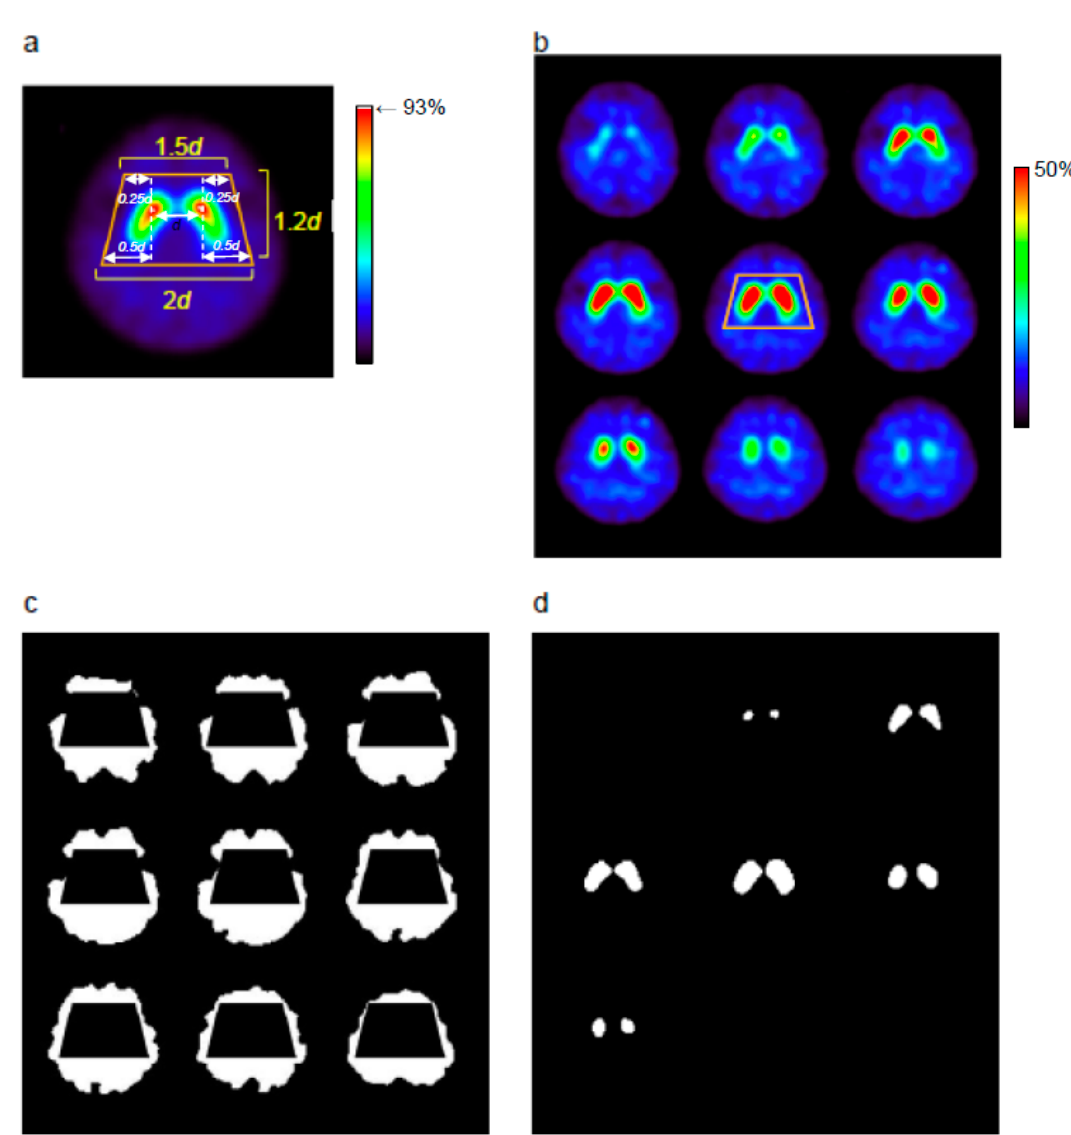
Figure 1. The trapezoidal volume of interest (VOI t ) was created automatically in the striatal region based on the maximum count voxels of the striata ( a ). The white color (> 93%) in the right caudate head indicates the peak count voxel in the right striatum, and the white cluster in the left caudate head includes the maximum voxel of the left side. The size of VOI t was determined by the distance ( d ) of the most intense voxels of the bilateral striata. The VOI for the reference region (VOI ref ) was determined from the whole brain region ( b ) after excluding low-count voxels of cerebrospinal fluid (CSF) space and VOI t ( c ). Finally, a bilateral VOI of the striatum (VOI st ) mask was created automatically by extracting the most intense 1052 voxels (= 11.2 mL) on each side [18] ( d ).